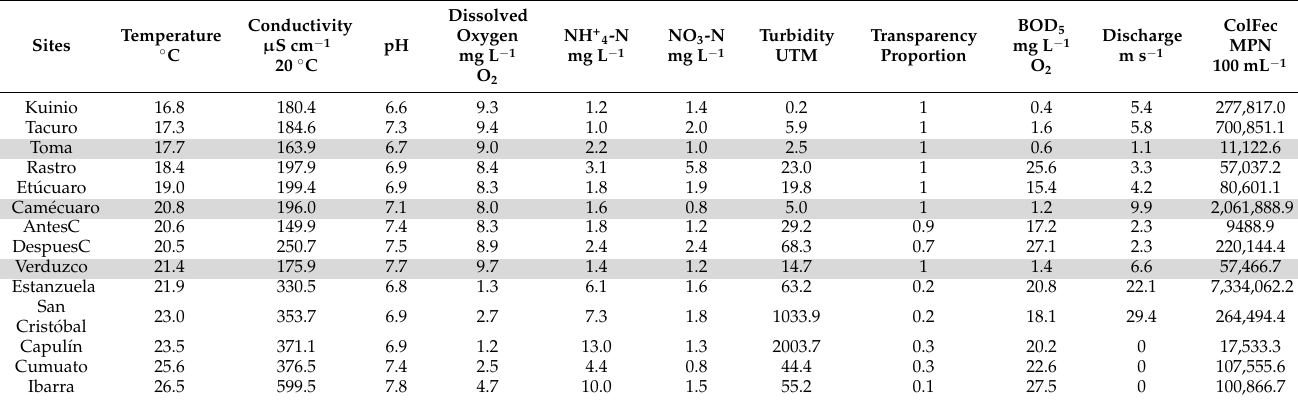
Table 1. Three-month average of chemical and bacteriological parameters recorded in the fourteen sites of the Duero river. The Grey line indicates sites related to springs. ColFec = fecal coliforms bacteria, MPN = most probable number, and AntesC = Antes Central de Abastos and Despu é sC = Despu é s Central de Abastos.